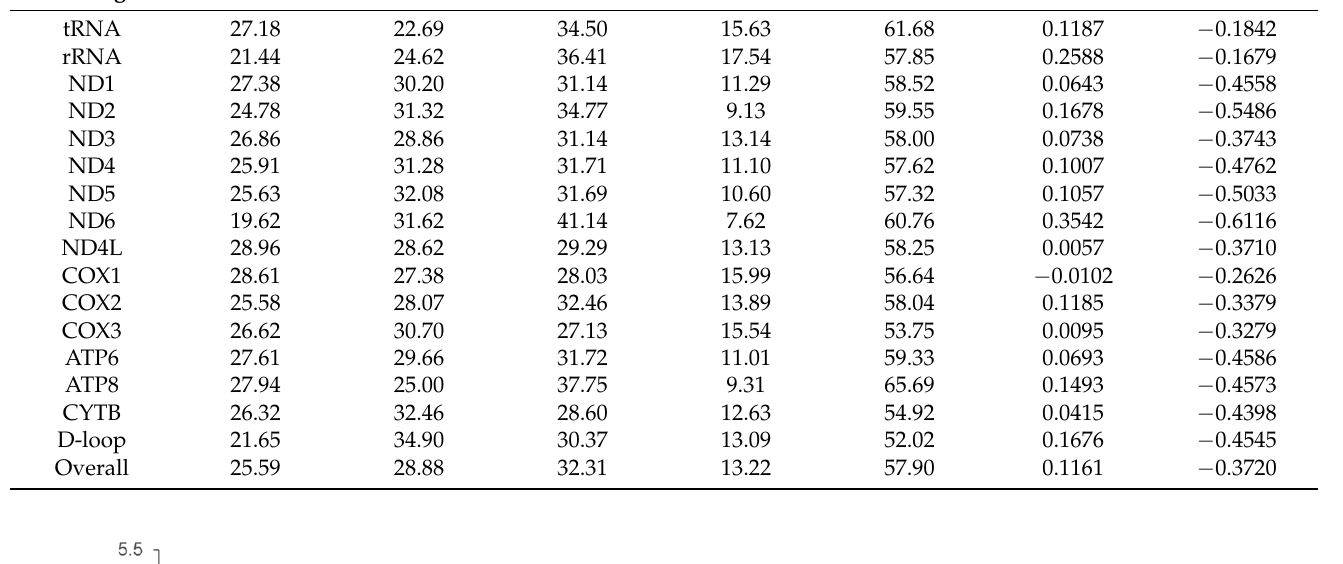
Table 3. Codon number and relative synonymous codon usage (RSCU) of Huaibei grey donkey mitochondrial DNA.